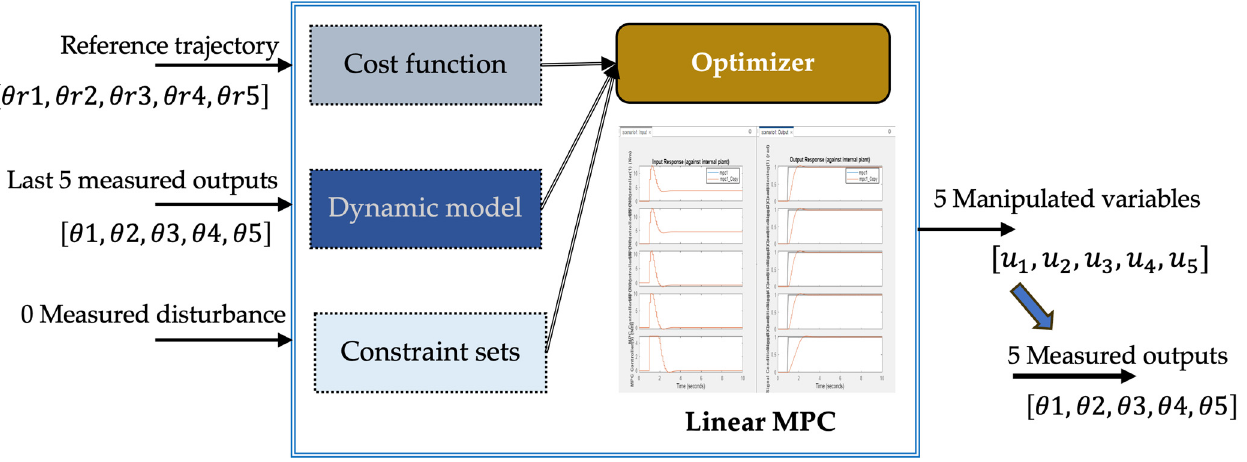
Figure 9. Inputs and outputs of MPC controller.